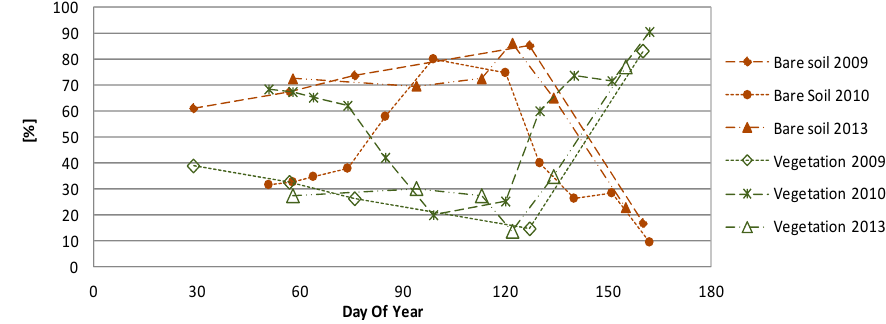
Figure 6. Fraction of soil and vegetated crop plots over the total area representing the monitored summer crops during 2009, 2010 and 2013.